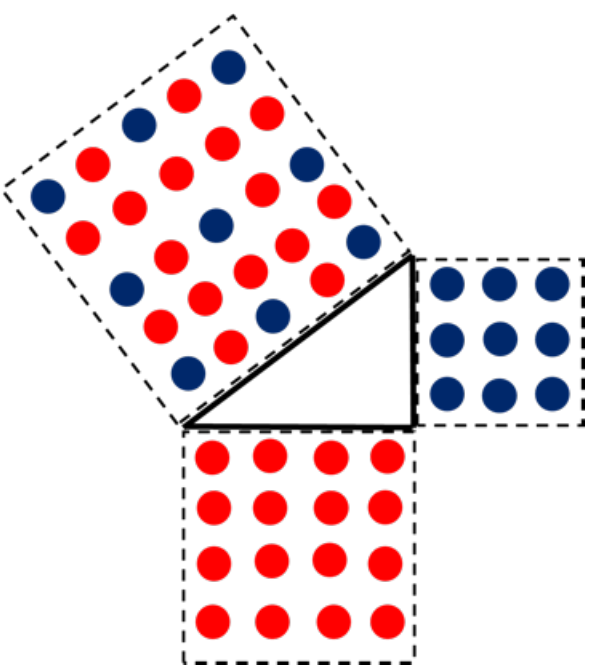
Figure 2. A chessboard that shows the empyrical derivation of the so-called Pytagora’s theorem on right triangles and the existence of the Pytagoric triplet 3,4,5.